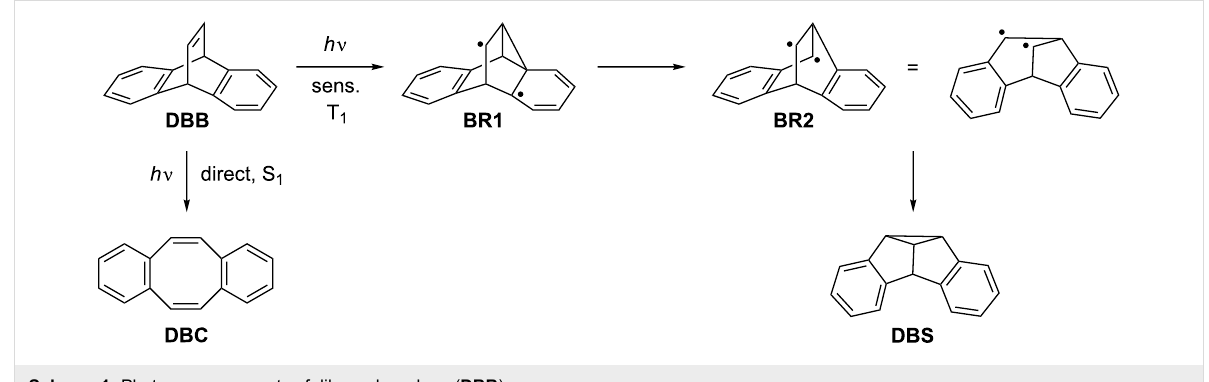
Scheme 1: Photorearrangements of dibenzobarrelene ( DBB ).